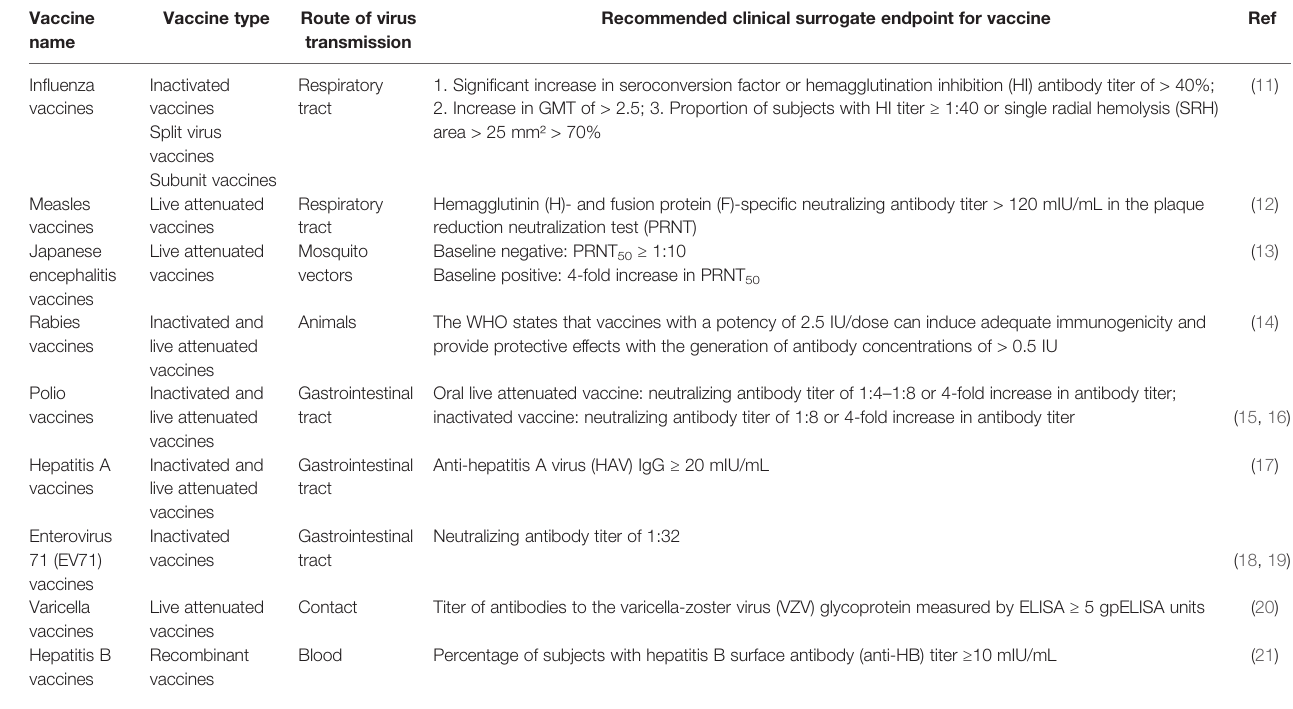
TABLE 1 | Recommended immunological surrogate endpoints for licensed viral